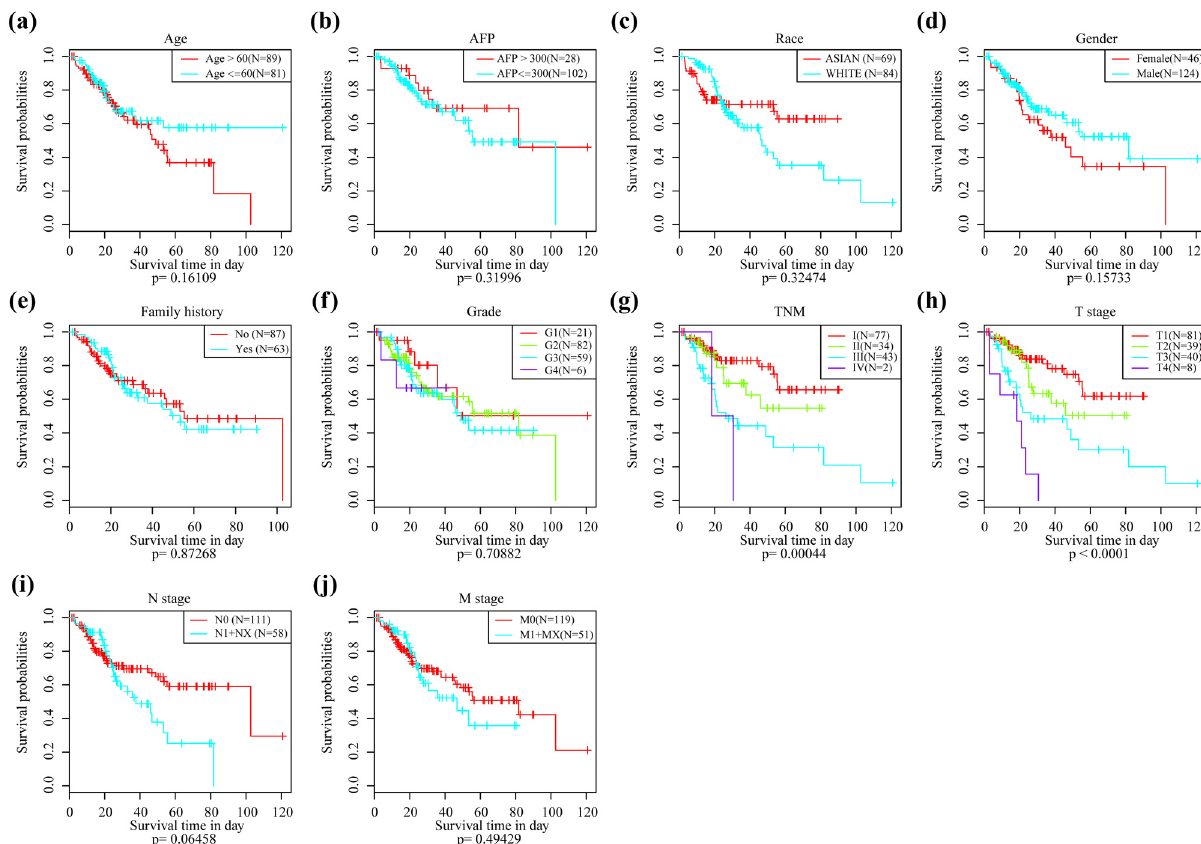
Figure S2: KM curve of ( a ) Age, ( b ) AFP, ( c ) Race, ( d ) Gender, ( e ) Family history, ( f ) Grade, ( g ) TNM phase, ( h ) T phase, ( i ) N phase and ( j ) M phase in HCC OS in the TCGA training